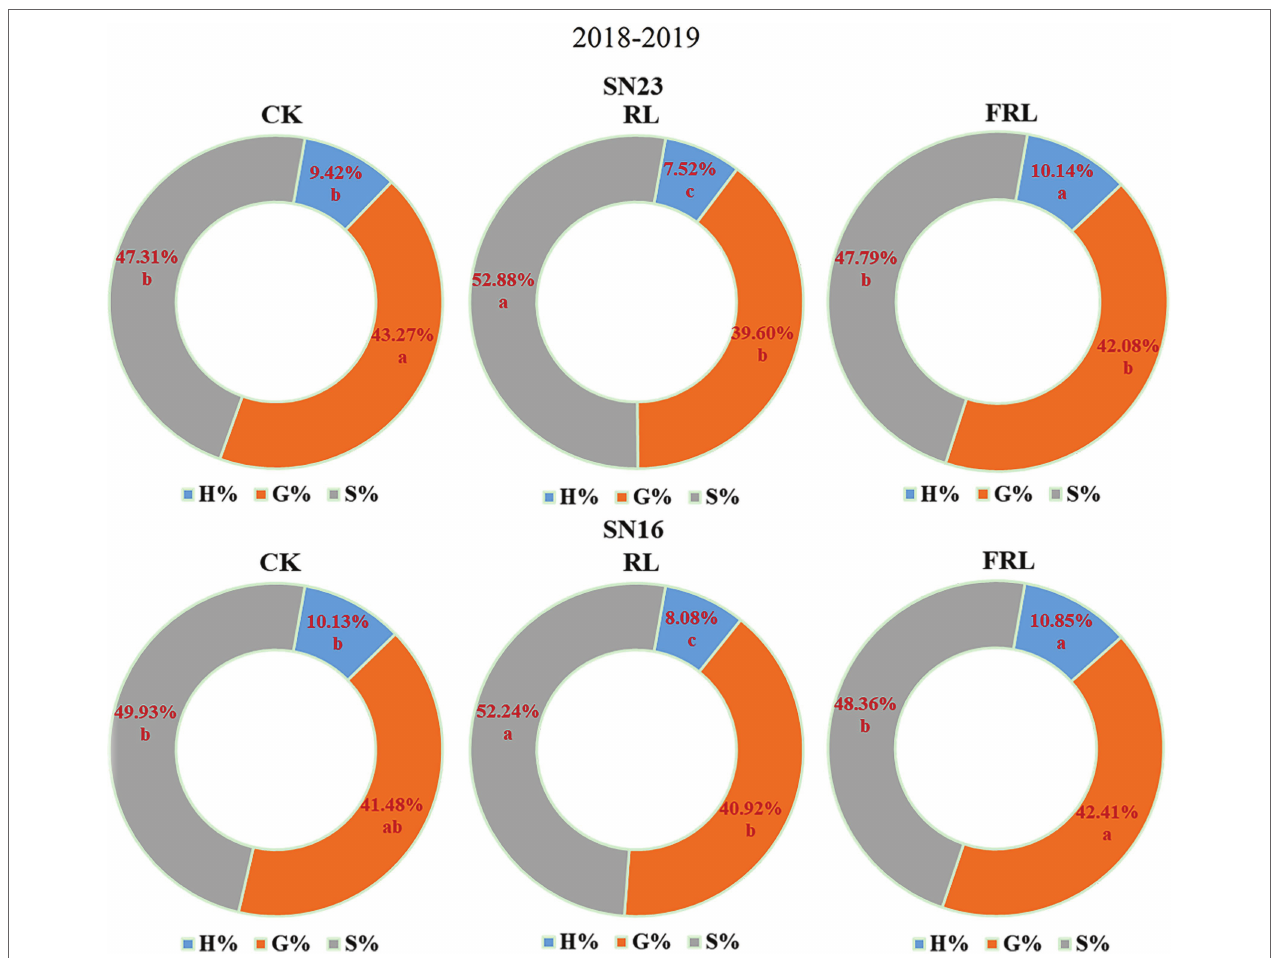
FIGURE 6 | The effect of light quality in population on lignin subunit percentage at the duogh stage in wheat in 2018–2019 growing seasons. SN16 and SN23 represent the lodging-sensitive cultivar Shangnong16 and the lodging-resistant cultivar Shangnong23. CK represents the normal light, RL represents the red light, and FRL represents far-red light. H, G, and S represent p-hydroxyphenyl lignin, guajacyl lignin, and syringyl lignin,